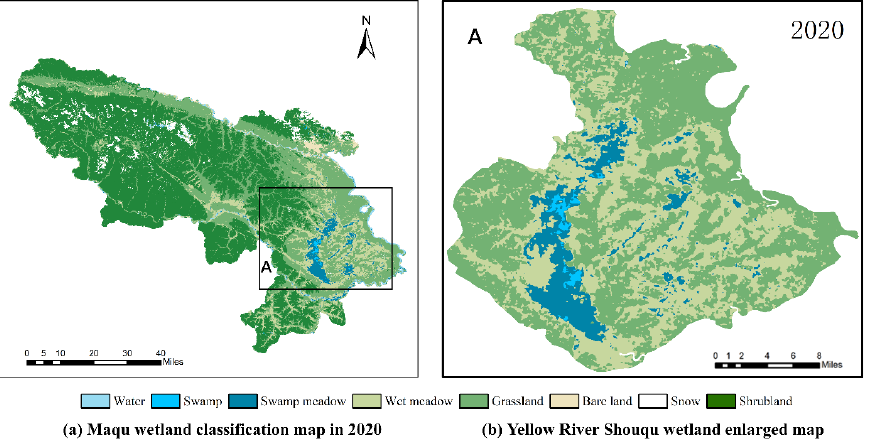
Figure 5. Maqu wetland classification map and partially enlarged map for 2020.